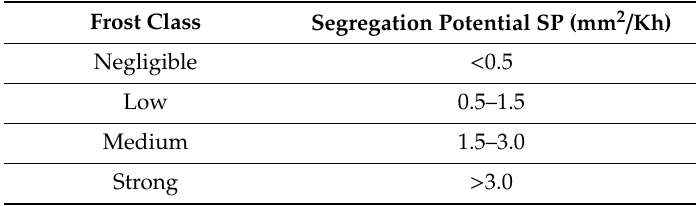
Table 3. Determination of the frost susceptibility of a soil type